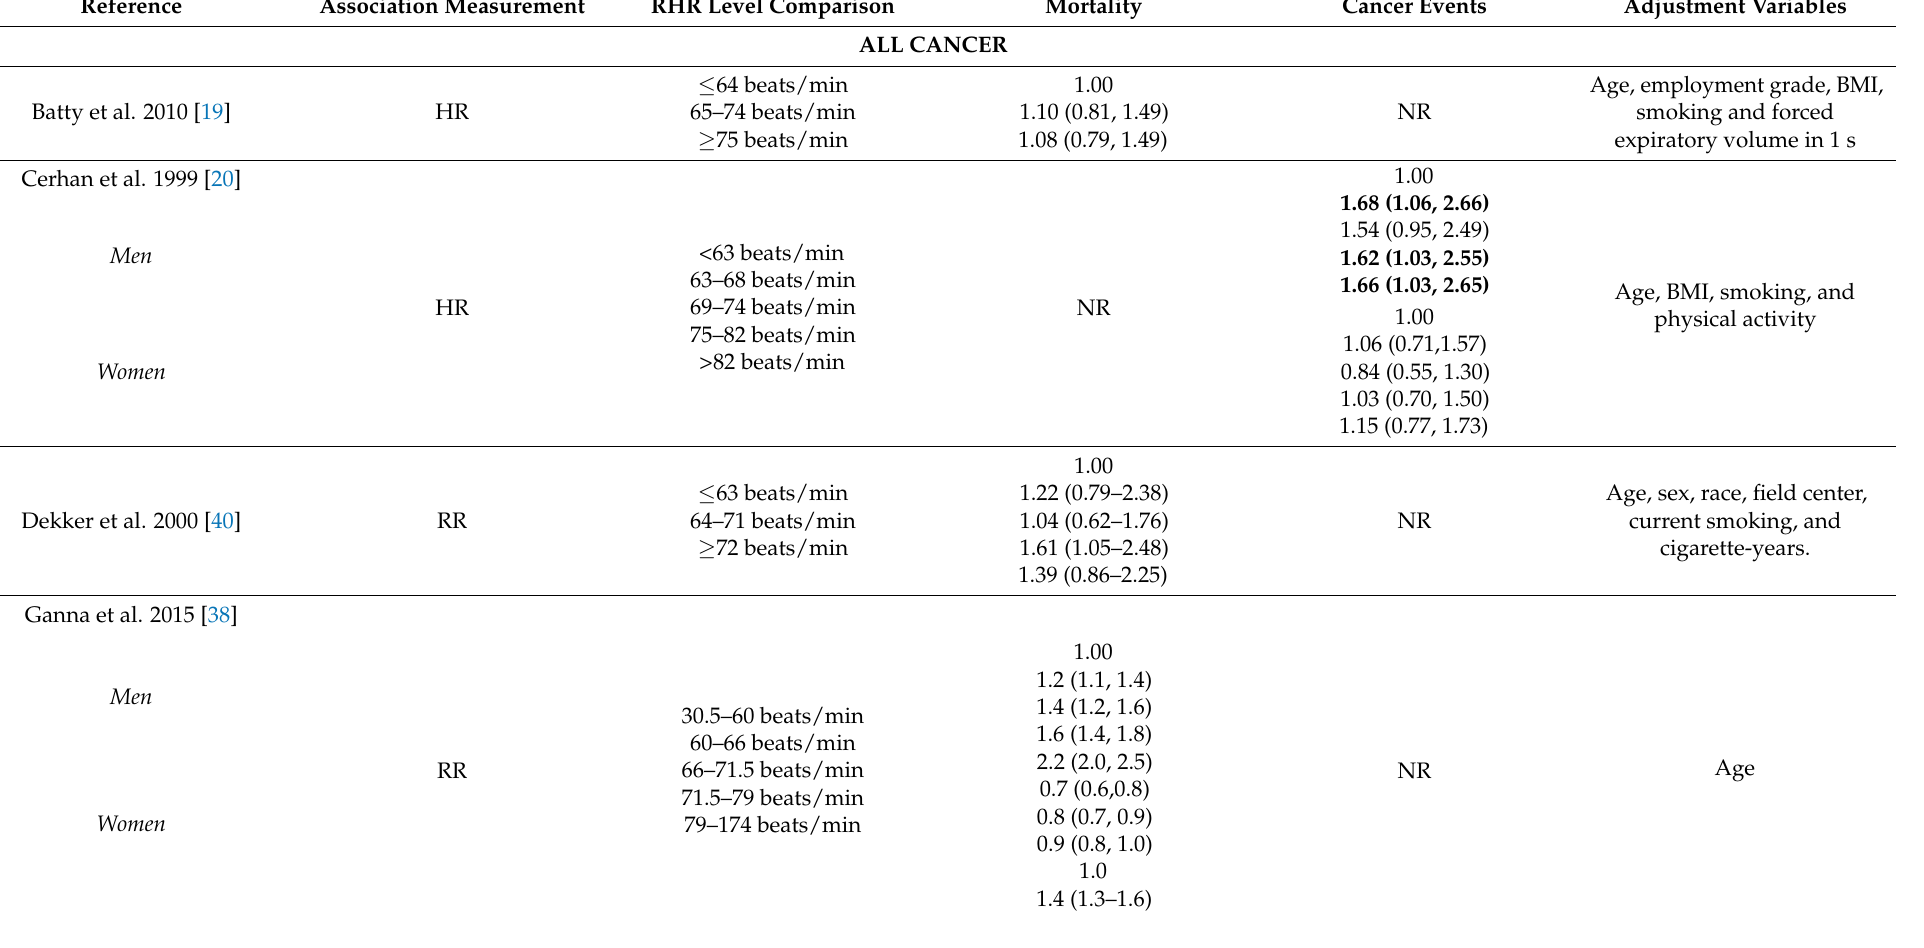
Table 2. Prospective cohort studies included in meta-analyses of resting heart rate and cancer